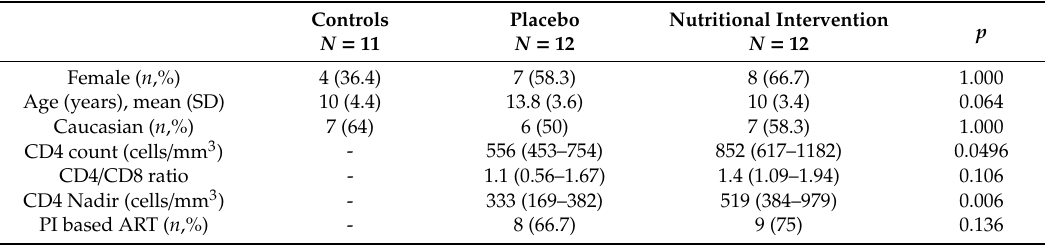
Table 2. Main characteristics of the study cohorts at baseline.